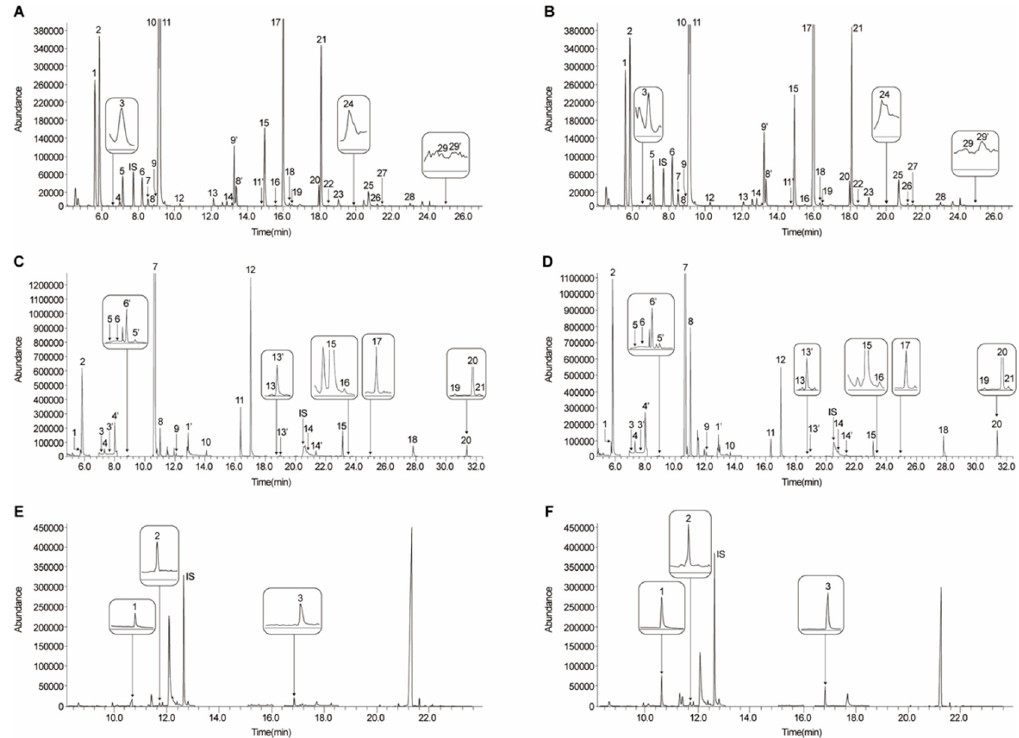
Figure 2. GC–MS chromatograms of 29 AAs, 21 OAs, and 9 PAs. SIM chromatograms of control and 5 days post MCAo rat brain. AAs from control ( A ) and MCAo rat brain ( B ) SIM chromatograms: 1 =